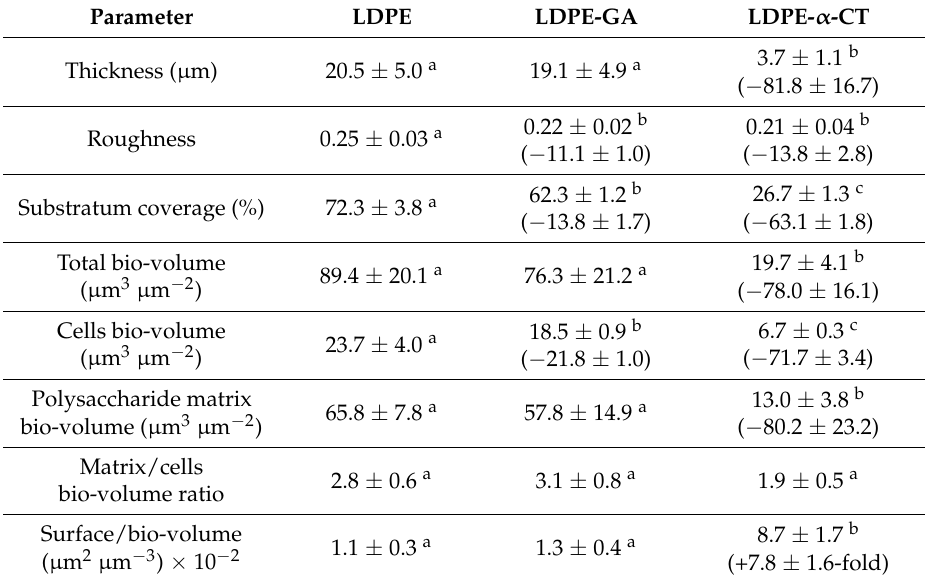
Table 1. Biofilm morphological parameters of biofilm grown on non-functionalized (LDPE, LDPE-GA) and functionalized polyethylene surfaces (LDPE- α -CT). In the brackets, percentage reduction/increase in comparison to the LDPE control sample is reported when significant. Data represent the mean ± standard deviation of four independent